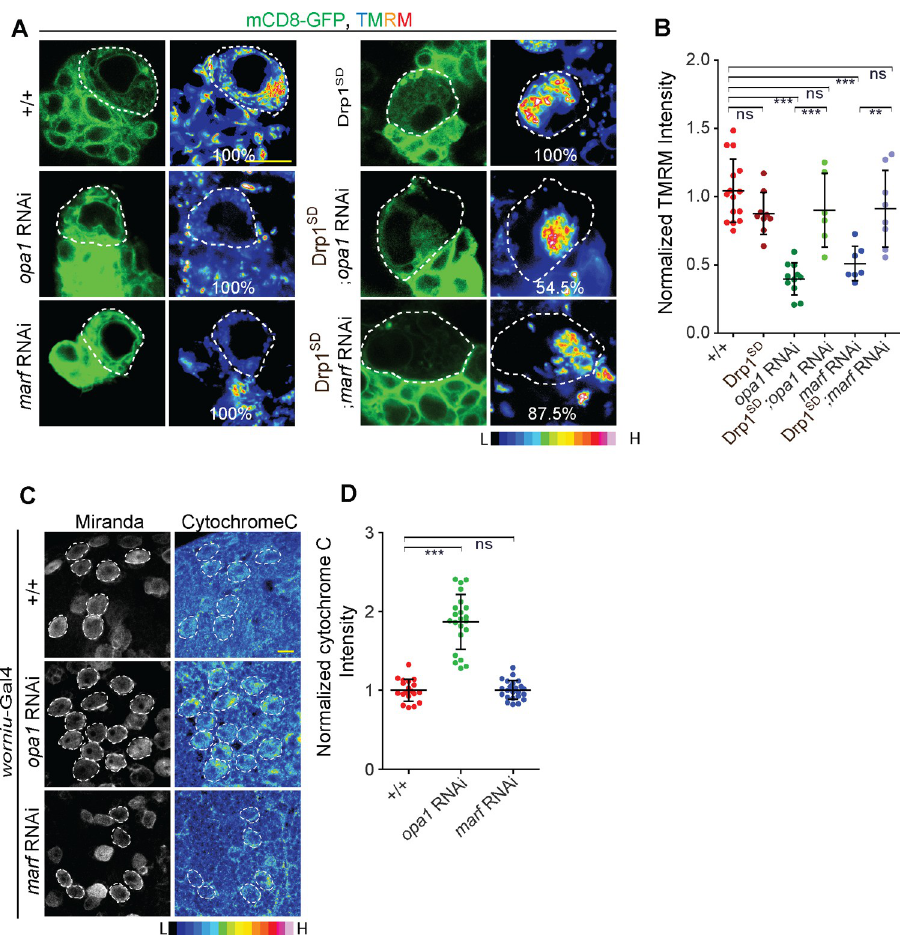
Fig 4. Drp1 SD overexpression in Opa1 or Marf depleted type II NBs rescues the reduced mitochondrial membrane potential. A, B: Representative images showing decreased TMRM intensity in opa1 RNAi and marf RNAi expressing type II NBs. Percentage of type II NBs showing similar intensity profile to the representative images is shown on the image panel for each genotype. pnt -Gal4, mCD8-GFP (+/+, 17 type II NBs, 8 brains), Drp1 SD (9,5), opa1 RNAi (16,5), Drp1 SD ; opa1 RNAi (11,4), marf RNAi (11,5), Drp1 SD ; marf RNAi (7,4). Scale bar- 10 μ m (A). Graph showing normalized TMRM intensities in +/+ (17 type II NBs, 8 brains), Drp1 SD (9,5), opa1 RNAi (16,5), Drp1 SD ; opa1 RNAi 7,4), marf RNAi (11,5), Drp1 SD ; marf RNAi (6,4) (B). C, D: Representative confocal images of larval NBs (C) showing increased cytochrome C staining in opa1 RNAi using worniu -Gal4. Analysis of cytochrome C intensity normalized with control (D). +/+ (19 NBs, 8 brains), opa1 RNAi (22 NBs, 7 brains), marf RNAi (23 NBs, 7 brains). B,D: Graphs show mean ± sd. Comparative analysis was done by using unpaired t-test. ns- non significant, �� - p < 0.01, ��� - p <